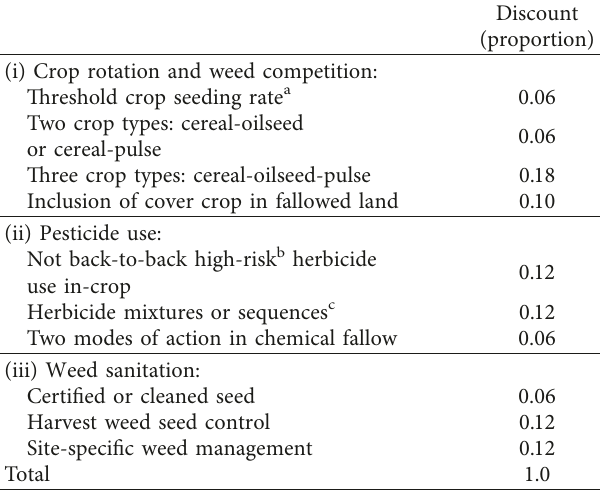
Table 3: Hypothetical crop insurance proportional or weighted discounts for varying levels of implementation of three potential best herbicide resistance management tactics and practices in annual crop systems in the Northern Great Plains of